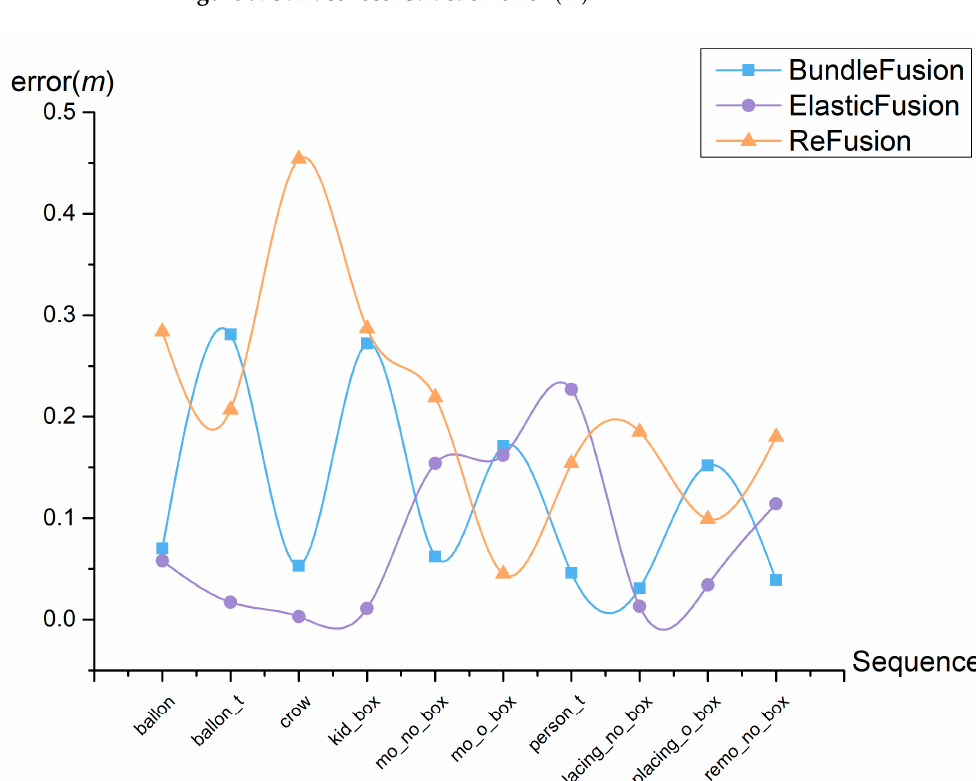
Figure 10. Errors between the proposed method and ReFusion, BundleFusion, and ElasticFusion.